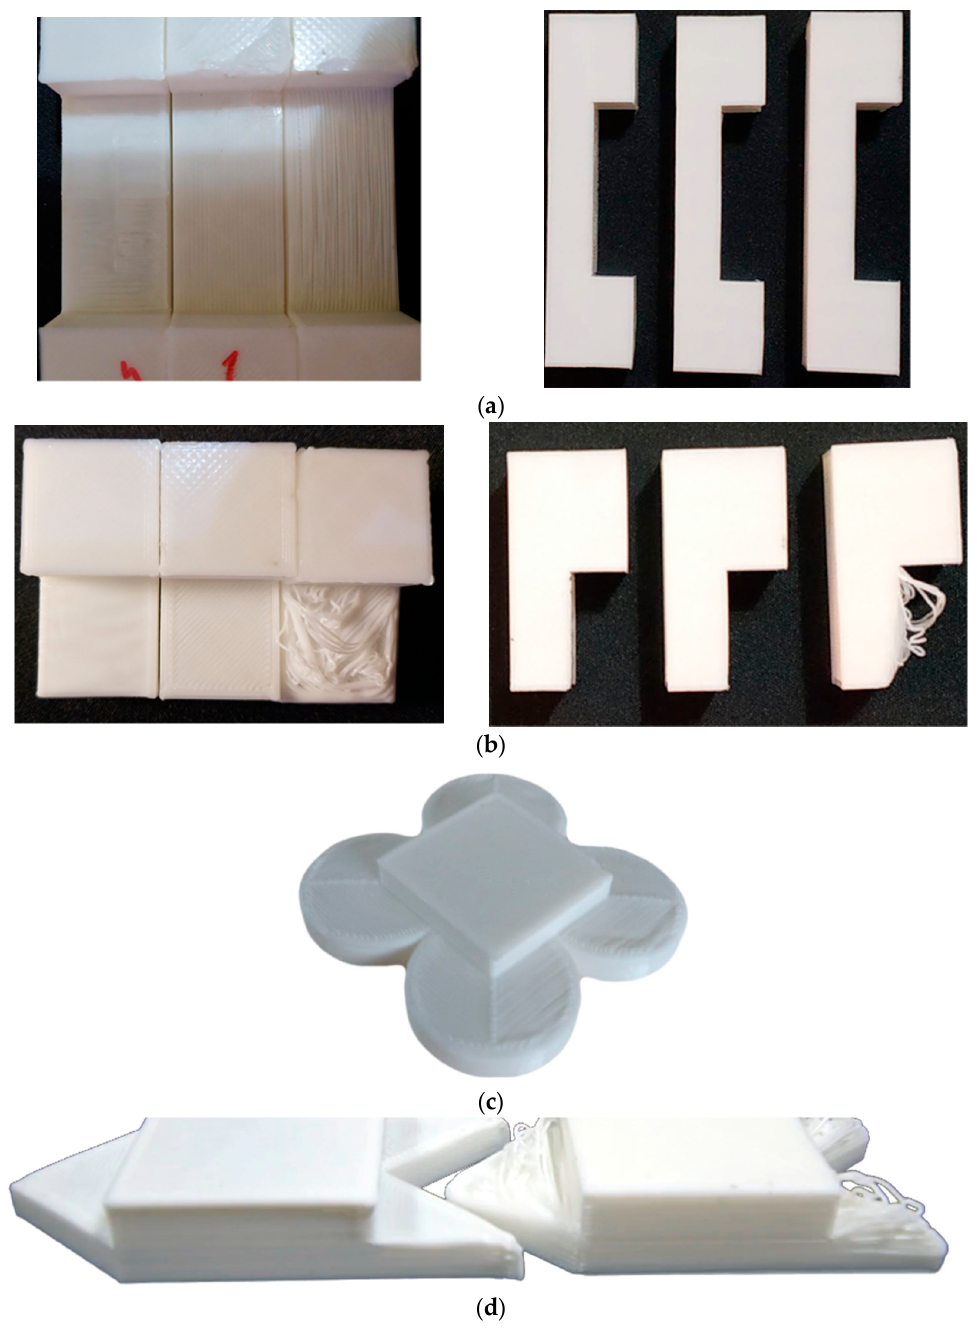
Figure 10. Printed samples: ( a ) bridge structure (left to right): Print on Air (PoA), supports, supportless; ( b ) rectangular overhang (left to right): PoA, supports, supportless; ( c ) circular overhang printed with PoA; ( c ) triangular overhang (left to right): PoA, supportless.